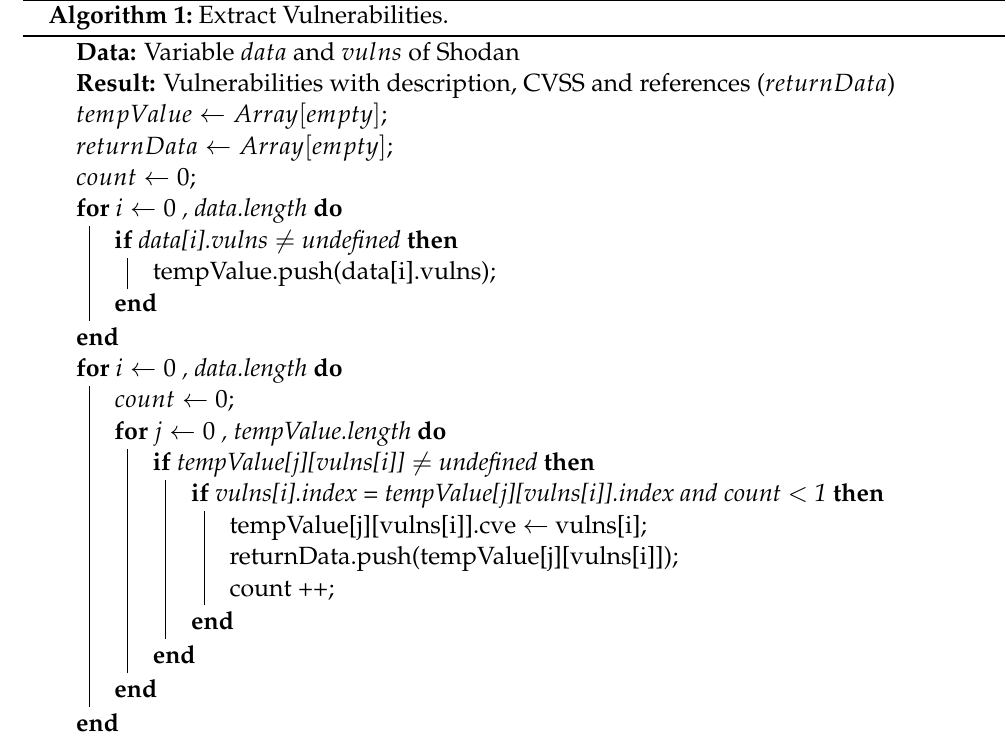
Algorithm 1: Extract Vulnerabilities.